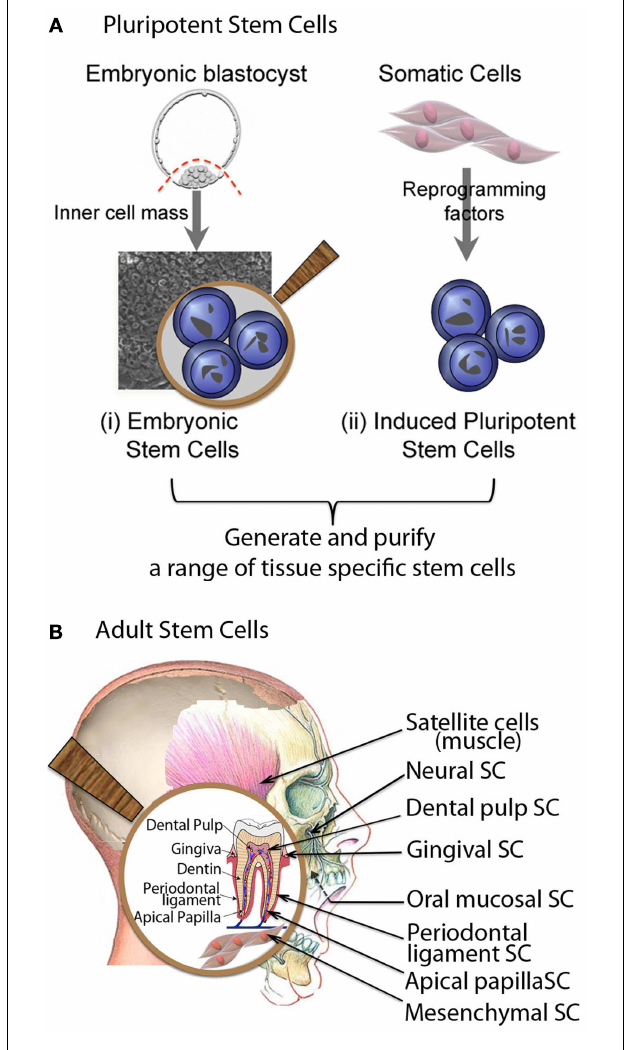
FIGURE 2 | Major sources of cells for craniofacial repair and regeneration. (A) Pluripotent stem cells, (B) Adult stem